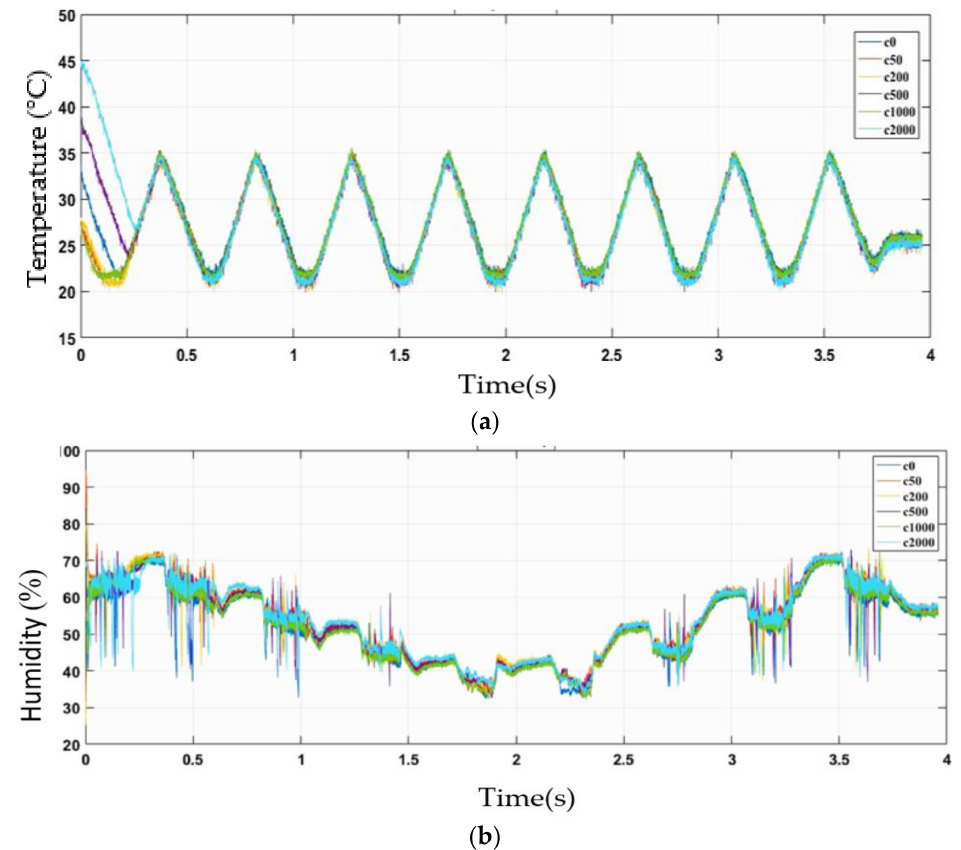
Figure 5. Two-dimensional plot of results using ethanol solutions of c0, c50, c200, c500, c1000, and c2000 concentration and humidity settings of h75, h65, h55, h45, h45, h55, h65, and h75: ( a ) tempera- ture setting and ( b ) humidity